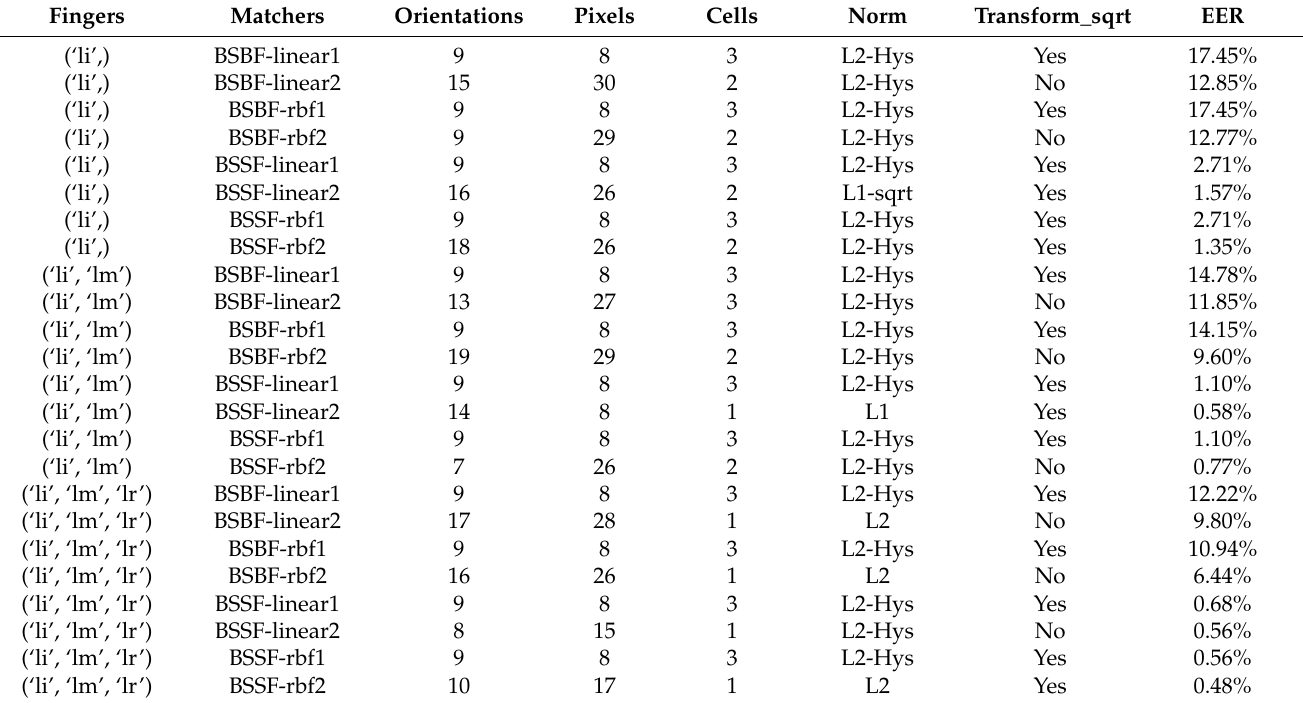
Table 1. Experimental results of the proposed system for SDUMLA-HMT.